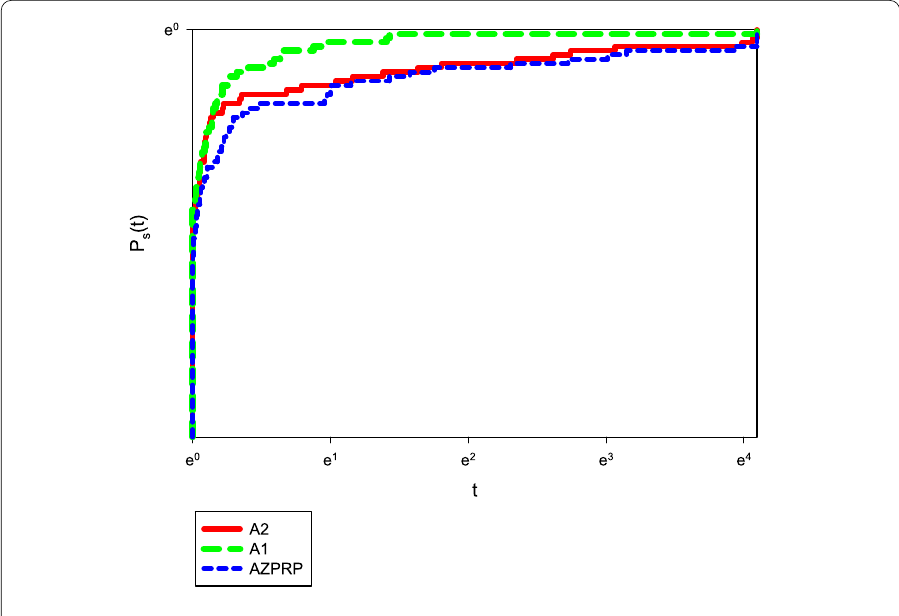
Figure 7 Performance profile based on the gradient evaluations